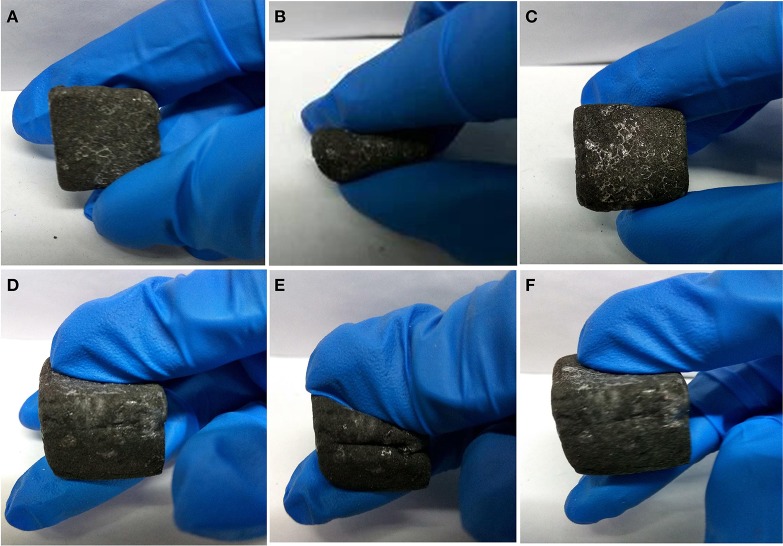
The flexibility and compressibility of PMMA-LiBH4/GMF: (A–C) and (D–F).